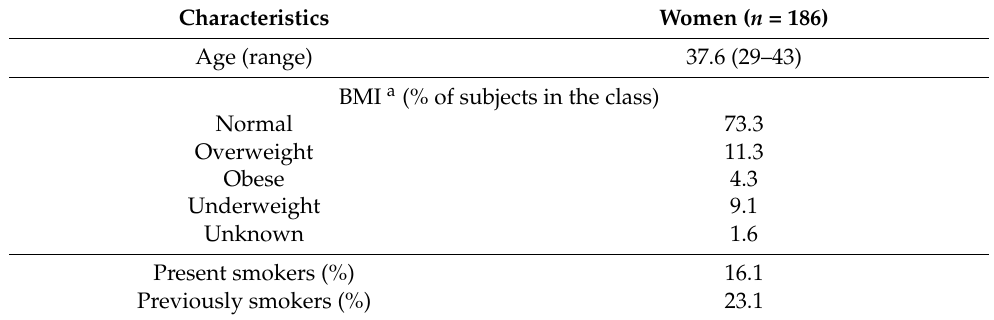
Table 3. Characteristics of the